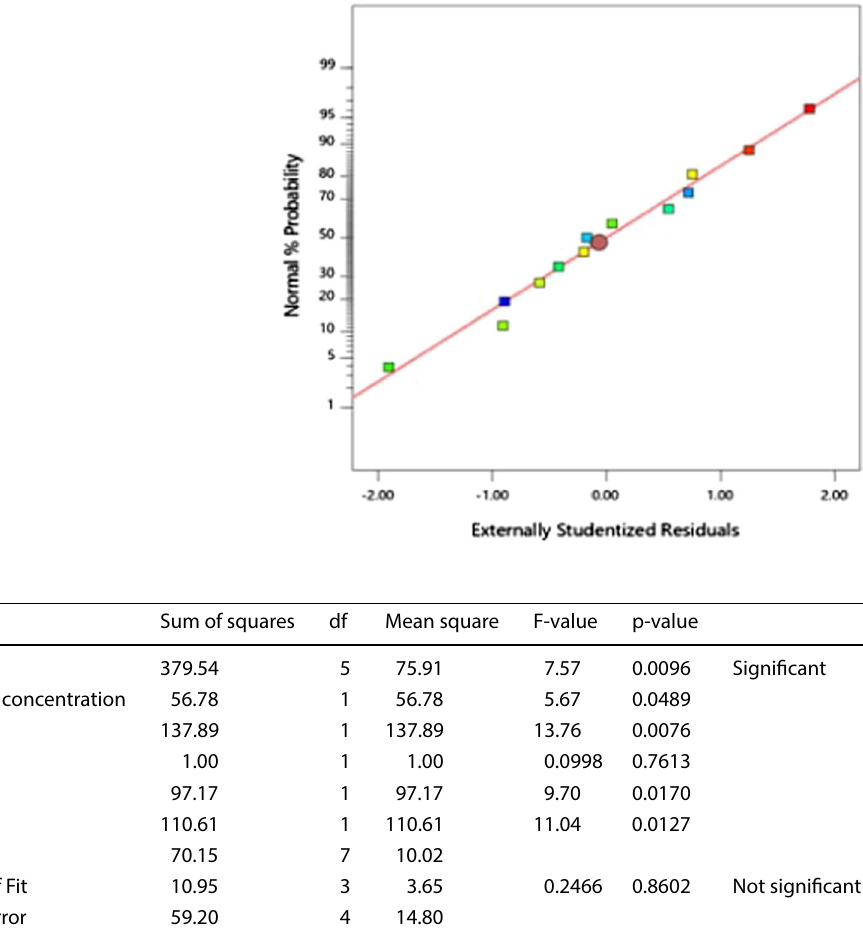
Fig. 2 Normality % probability vs. residual plot for percent esterification